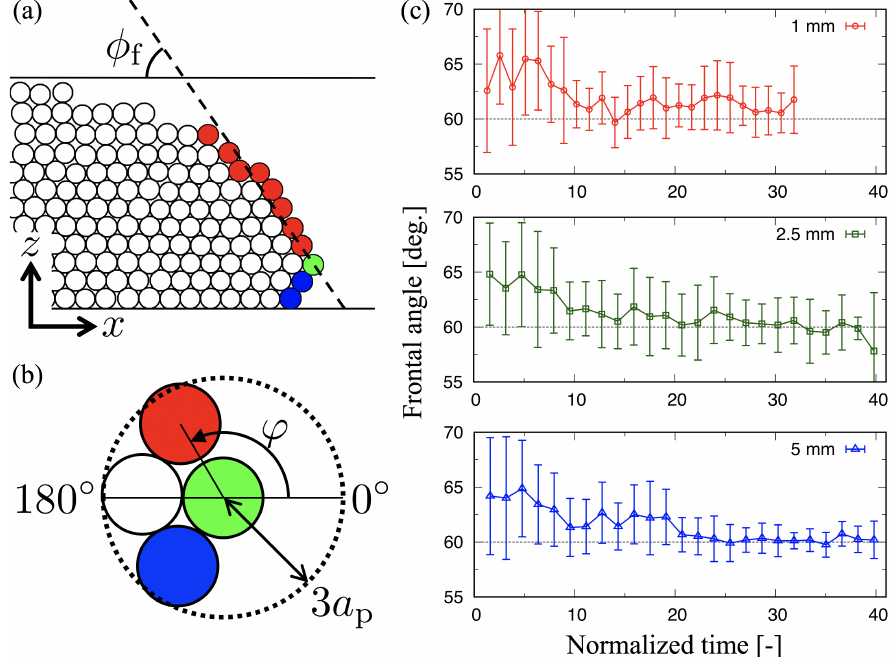
Figure 11. Definition and temporal variations of frontal angle φ f in the x – z plane (triangular set-up). ( a , b ) The green particle is at the forefront of the granular flow, and the neighbor particle is selected within 3 a p and ϕ = 0 ◦ -180 ◦ . The red particle is selected in a similar way, and the green particle contributes to φ f , whereas the blue particle is excludable. The dashed black line is drawn using the least-squares method against the coordinates of the red and green particles. ( c ) The mean and standard deviation of 20 simulations are denoted by a point and error bar,